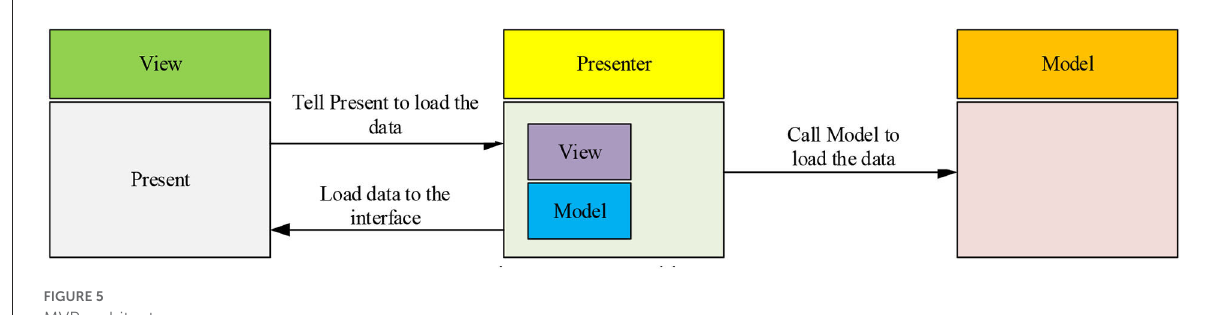
FIGURE5 MVP architecture.